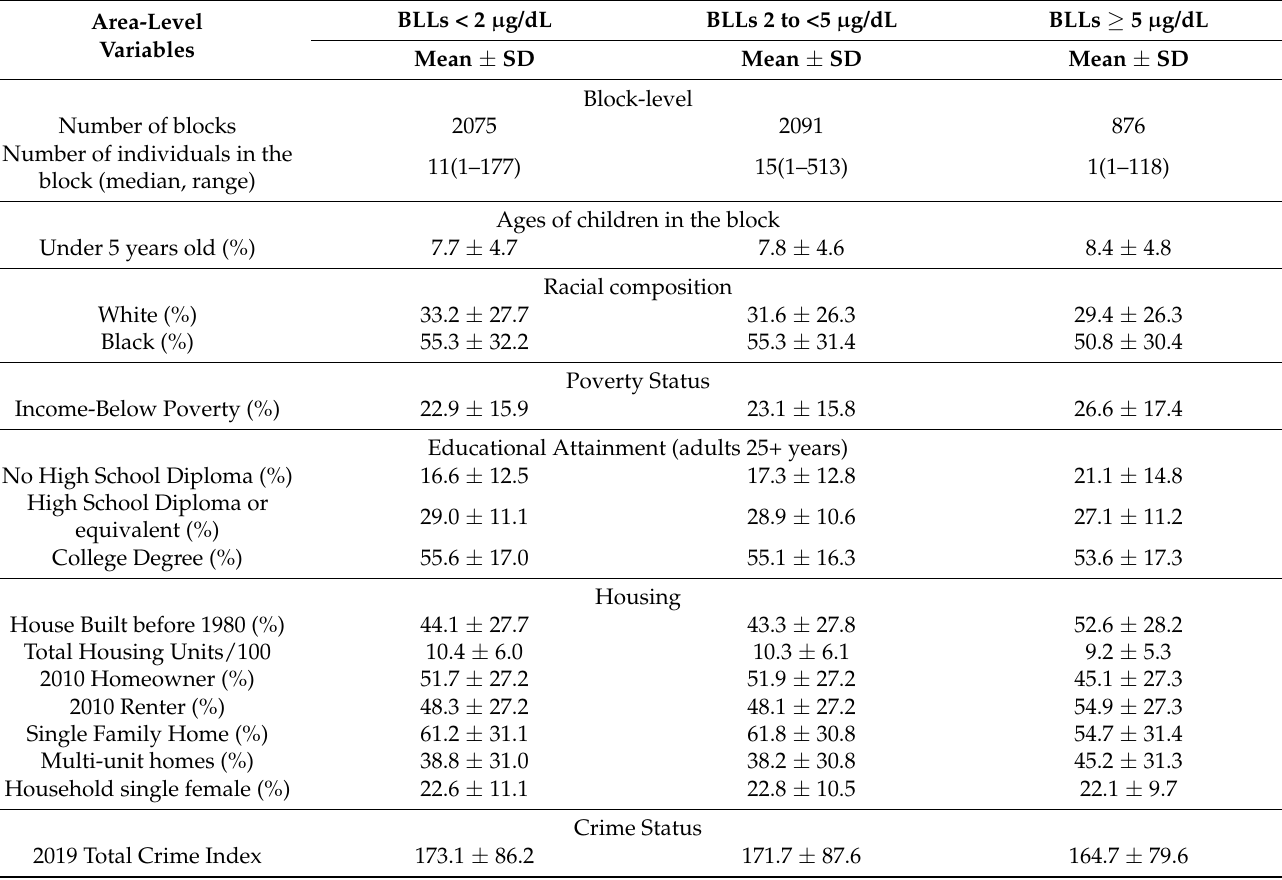
Table 2. Area-level characteristics for the household location of 93,162 children aged 0–72 months living in 20 counties in or near